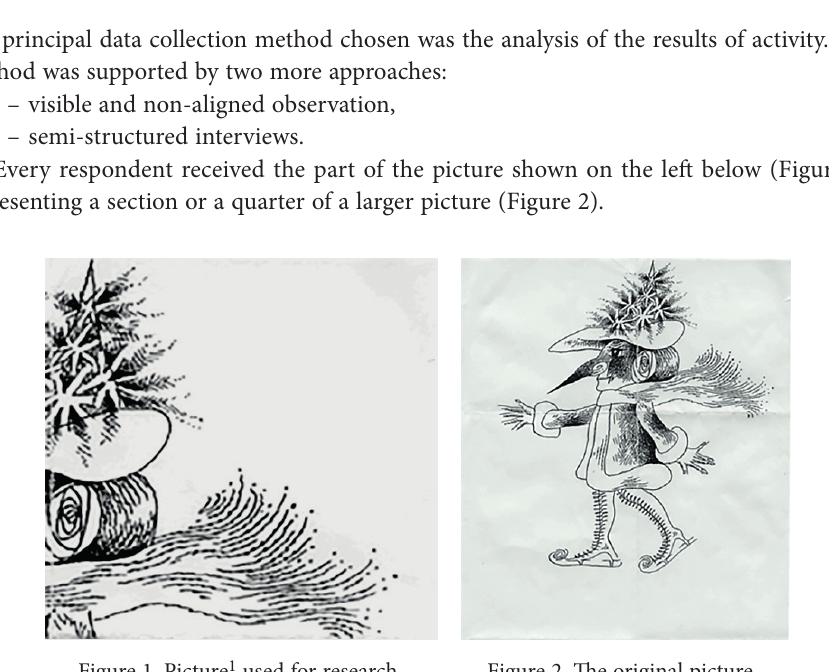
Figure 1. Picture 1 used for research Figure 2. The original